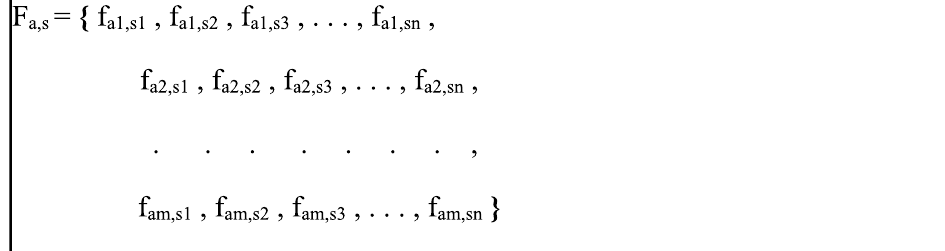
Fig. 2 Feature set of proposed system